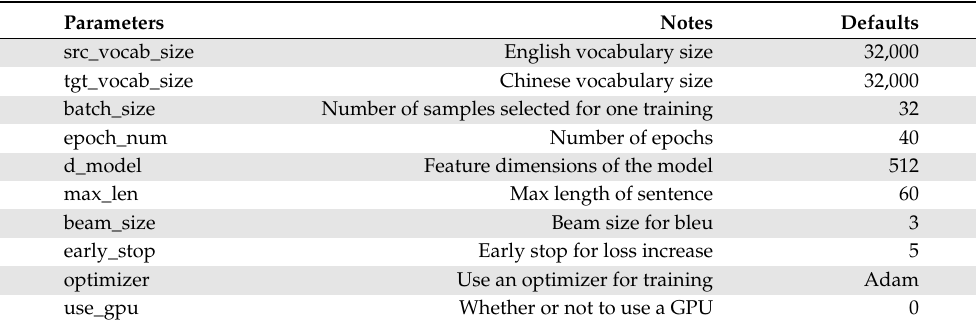
Table 1. The configurable training parameters.